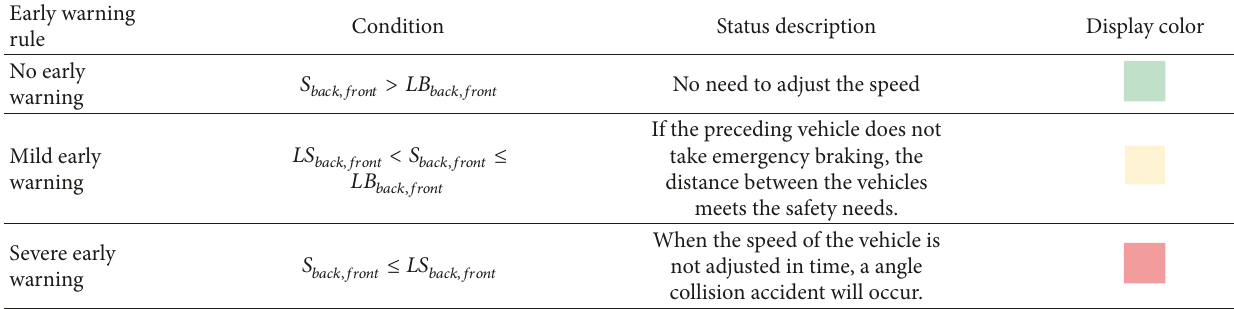
Table 3: Introduction to early warning rules.